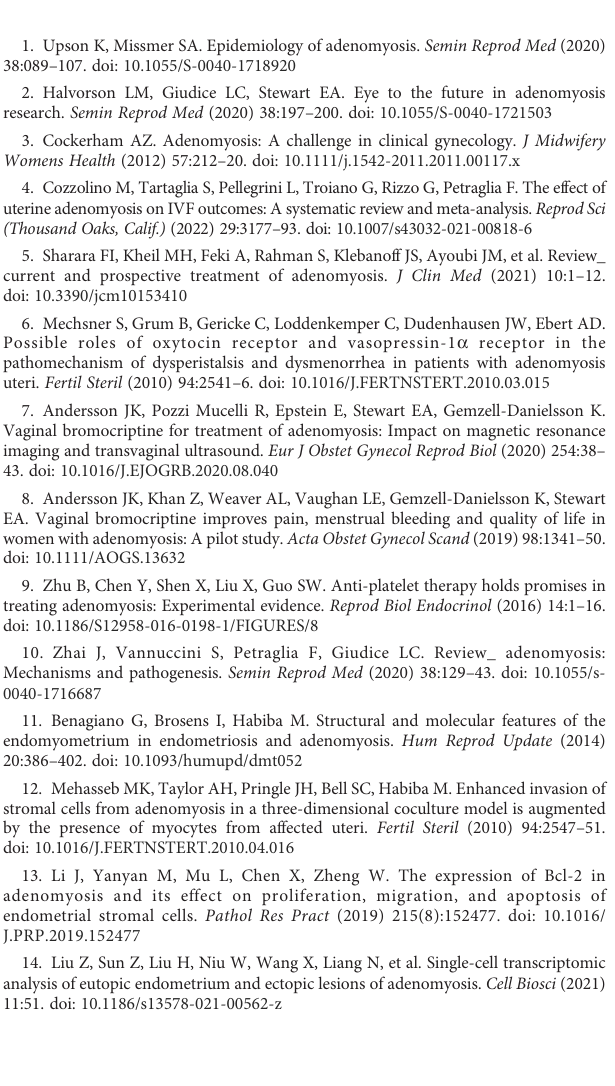
SUPPLEMENTARY FIGURE 1 Prolactin level in conditioned medium. ns indicates no signi fi cant difference between the group with adding bromocriptine and without adding